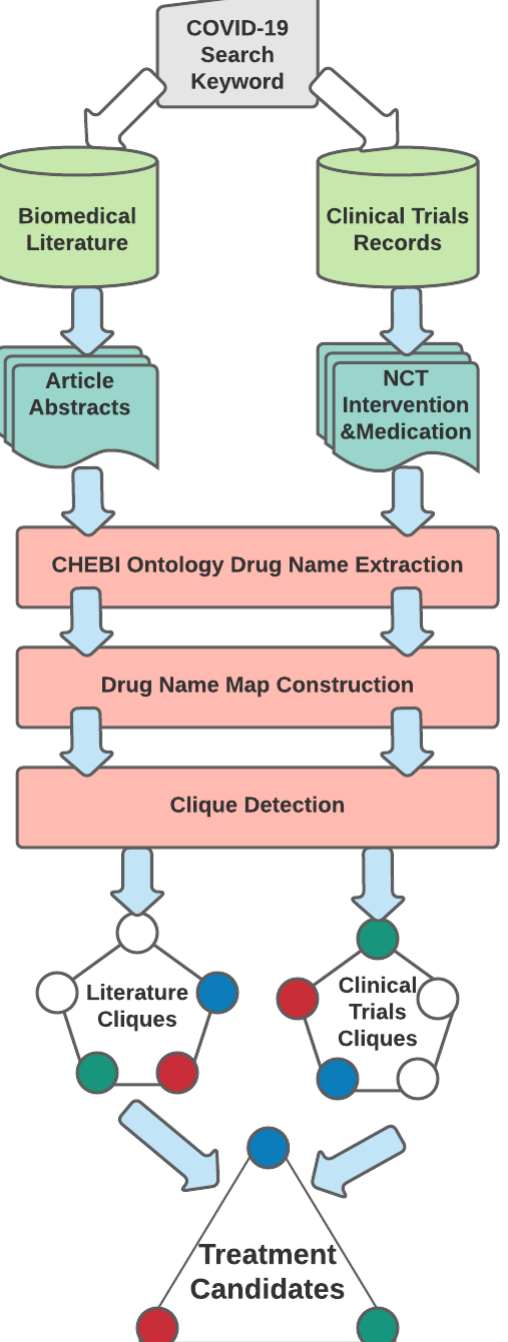
Figure 1. Workflow of the framework starting with the raw inputs (biomedical publications and clinical trial intervention and medication recrods). There are three steps: (1) ChEBI ontology term extraction, (2) Network construction from the associated drugs, and (3) applying a clique finding algorithm to detect the cliques. The final step is the discovery of comparing and matching cliques found in the two sources and compared for similarities. The intersection consititutes a candidate COVID-19